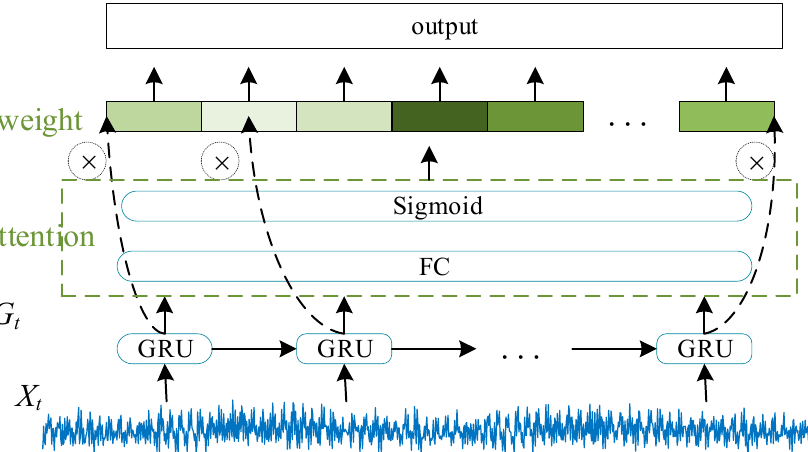
Figure 2. GRU temporal module based on an attention